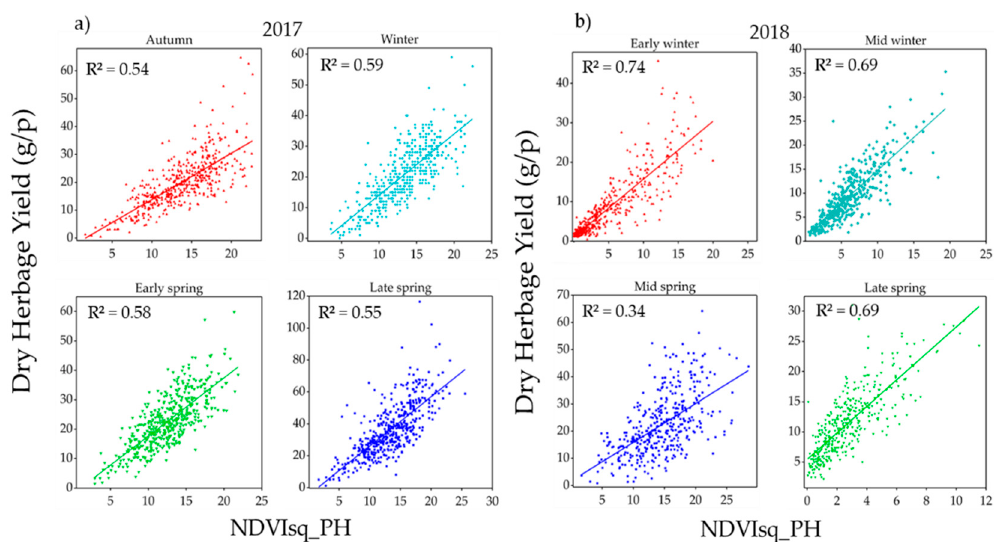
Figure 7. Scatterplots of ( a ) squared NDVI ‐ value extracted from UAS ‐ based multispectral imaging and plant height (NDVIsq_PH) vs. dry herbage yield measurements of single plants in four seasons of 2017; ( b ) NDVIsq_PH vs. dry herbage yield measurements of single plants in four seasons of 2018. p ‐ value < 0.001 for all regression equations.